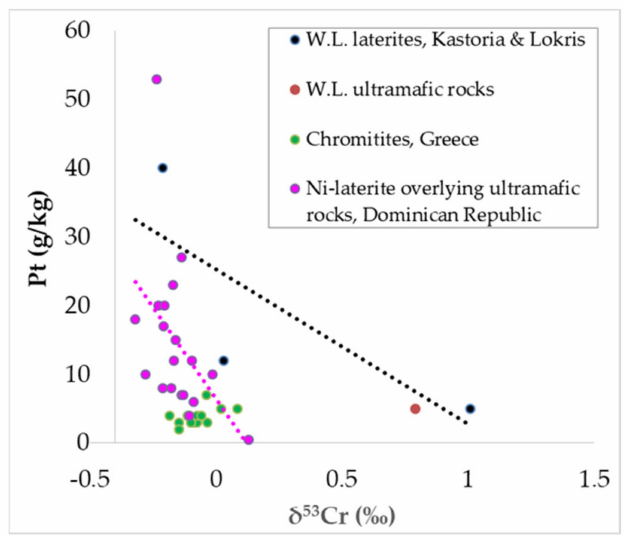
Figure 13. Plot of Pt versus δ 53 Cr values for Fe–Ni ± Co laterites, chromitites, and weathered ultramafic rocks from Greece and the Dominican Republic. Data from